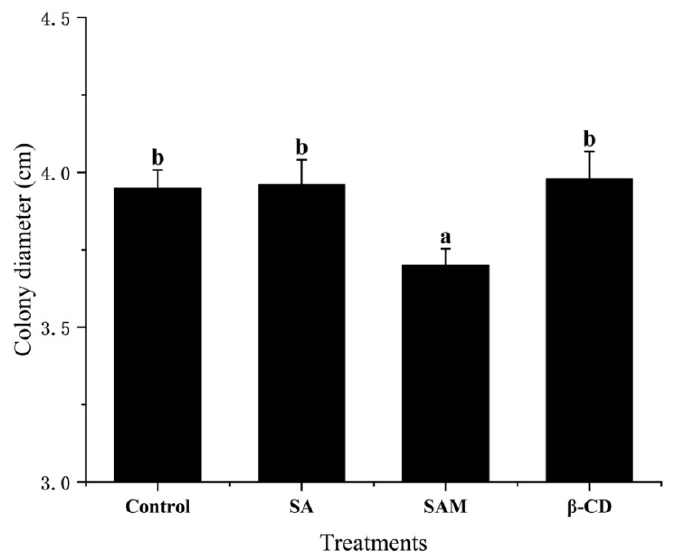
Figure 1. Effect of SAM on control of Penicillium expansum colony diameter on potato dextrose agar after 7 days of storage at 28 °C. SA, salicylic acid; SAM, salicylic acid microcapsule; β - CD, β -cyclodextrin. Control group was prepared with sterile distilled water. Vertical bars represent standard errors. Different letters show a significant difference ( p < 0.05).